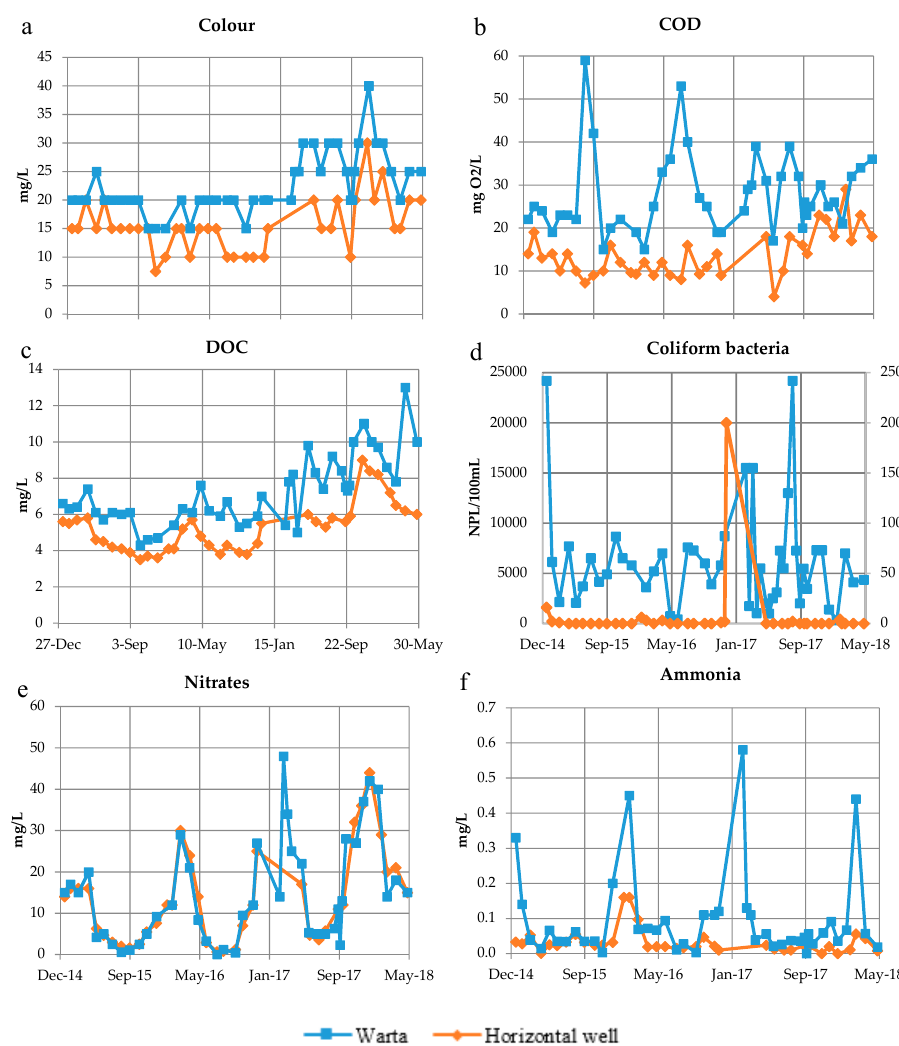
Figure 5. Temporal changes of selected parameters in the horizontal well (HW) and the Warta River. ( a ) Colour, ( b ) COD, ( c ) DOC, ( d ) coliform bacteria, ( e ) nitrates, ( f ) ammonia. Preliminary results show the presence of some pharmaceutical compounds and other micropollutants in both source water and bank filtrate (Table 2). In total, 30 micropollutants were analysed. The following pharmaceutical residues were detected in the Warta river, but not in bank filtrate: diclofenac (15 ng/L), iohexol (20 ng/L), iomeprol (20 ng/L), iopamidol (20 ng/L), metoprolol (10 ng/L), and theophylline (40 ng/L). The pharmaceutical residues that were not found in river water nor in bank filtrate were as follows: 4-DMA-antipyrin, 4-IP-antipyrine, atenolol, bezafibrate, diazepam, loratidin, naproxen, paracetamol, phenazone, primidone, sulfadiazine, theophylline, aspartam, chloramphenicol, gemfibrozil, and